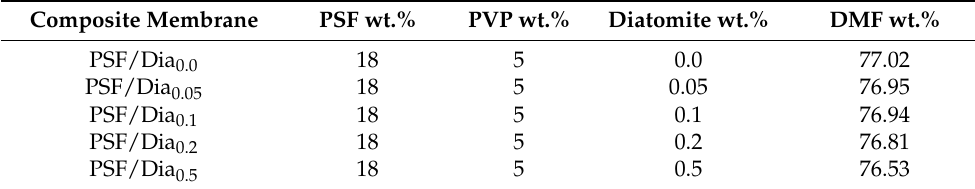
Table 1. Polymer dope solution composition and nomenclature of membranes. Composite